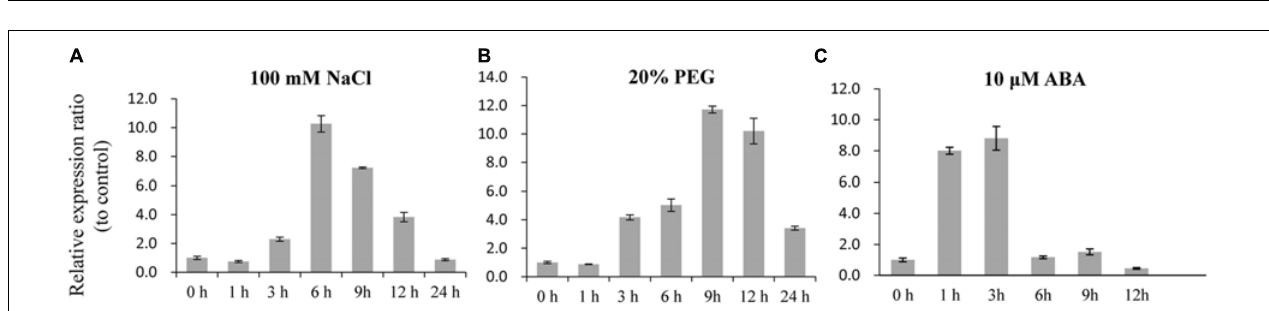
FIGURE 1 | Expression pattern of SiLTP . (A) Semi-qRT-PCR analysis of SiLTP in various foxtail millet organs. (B–D) Histochemical analysis of the SiLTP promoter::GUS expression in a transgenic Arabidopsis root (B) , 10-day-old leaf (C) , and inflorescence (D) .